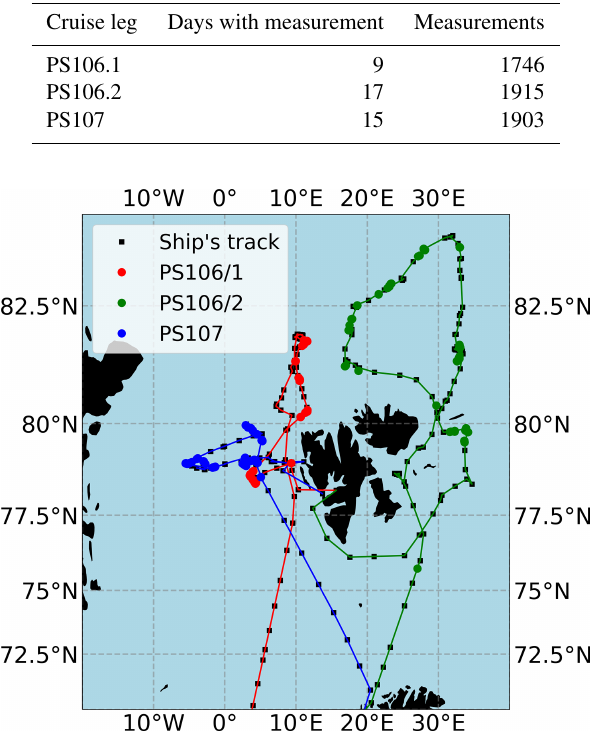
Figure 1. Map of the measurement area. Red markers indicate mea- surements during PS106.1 (24 May 2017 until 21 June 2017); green markers indicate measurements during PS106.2 (23 June 2017 until 19 July 2017). Blue markers indicate measurements during PS107 (22 July 2017 until 19 August 2017). The black squares show the ship’s